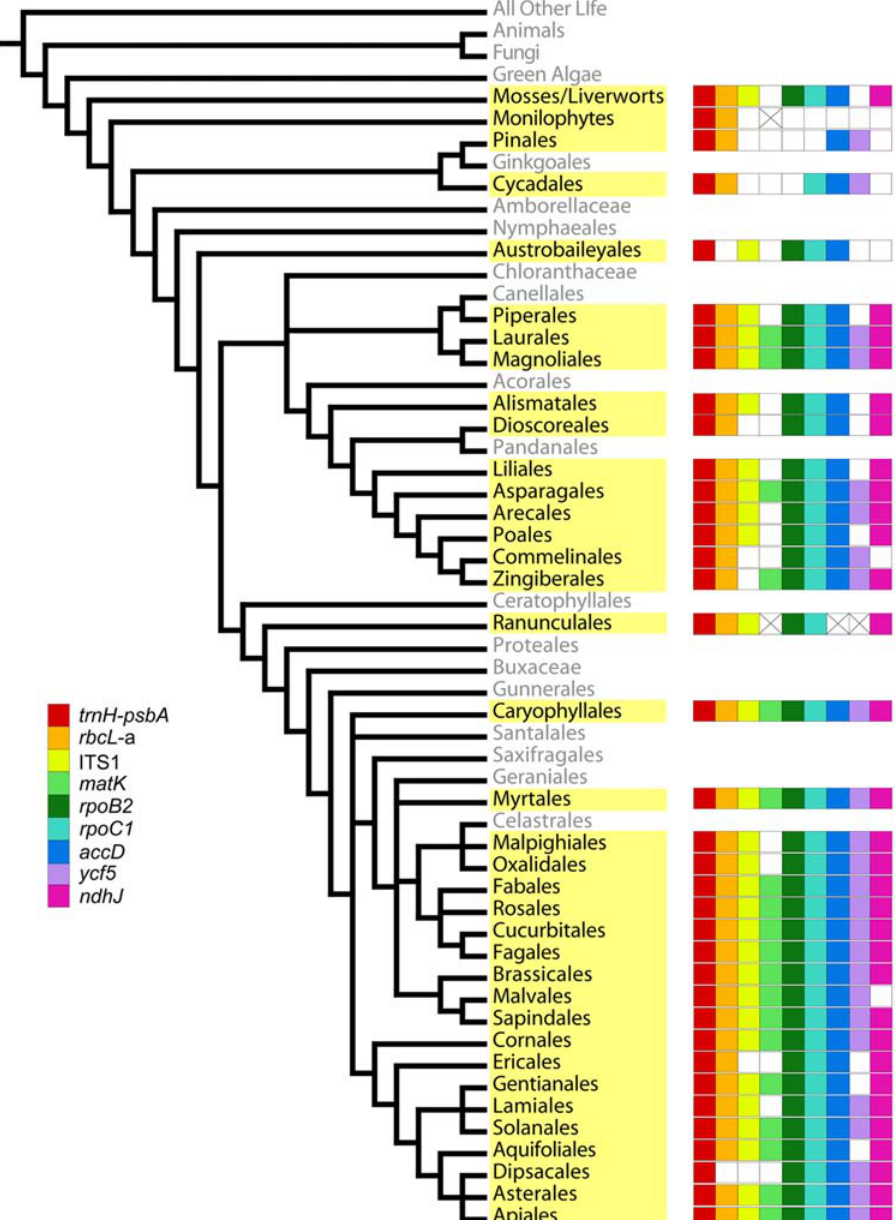
Figure 1. Phylogenetic distribution across land plants of included taxa and PCR success of tested loci. The cladogram indicates the major land plant lineages [34–35]. The lineages sampled in this study are highlighted in yellow. The success of each colored-coded primer in amplifying at least one species is indicated for each of the lineages; open white boxes indicate primer failure in all taxa tested; white boxes with an ‘‘X’’ indicate missing